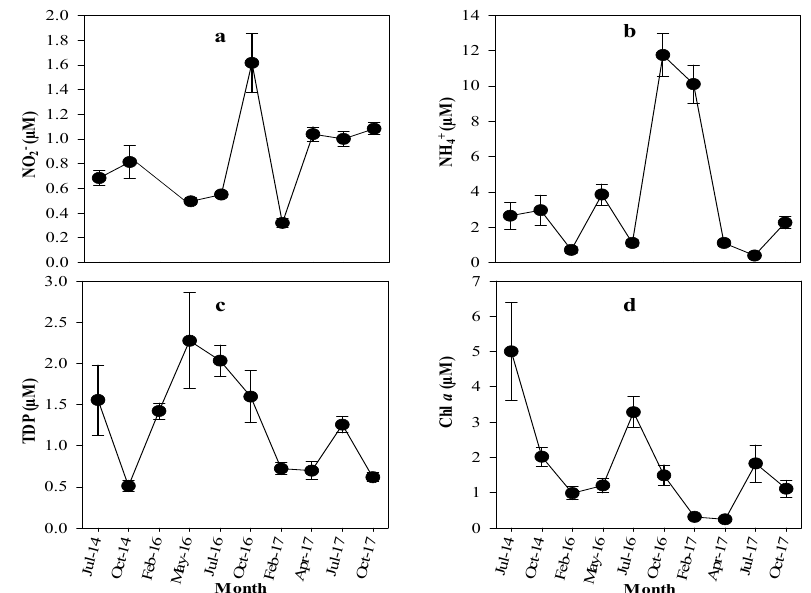
Figure 2. Temporal variation of nutrients; NO 2 − ( a ), NH 4+ ( b ), TDP (total dissolved phosphorus) ( c ) and Chl. a (chlorophyll a ) ( d ) in Maryland Coastal Bays. Mean monthly values are based on measurements at 13 sites.